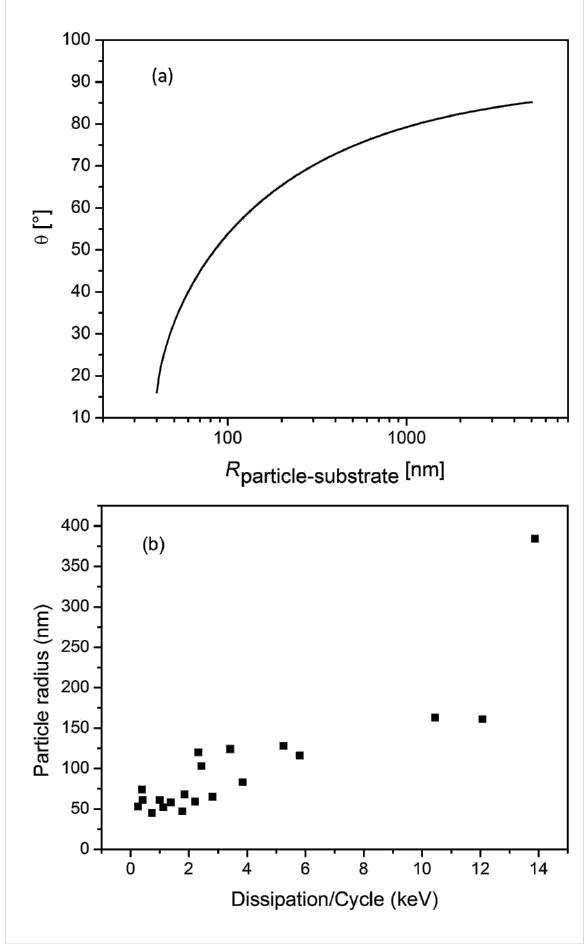
Figure 1: (a) Theoretically predicted trajectory angles of nanoparticles manipulated on an arbitrary surface as a function of the particle–sub- strate contact radius with b = 39 nm. (b) Calculated particle radius and energy dissipation obtained by using Equation 2 with an experimen- tally determined phase-lag and trajectory angle of the manipulated particles adsorbed on mica. The amplitude was A = 23 nm, the Q-factor = 7 and A 0 = 1.2 A